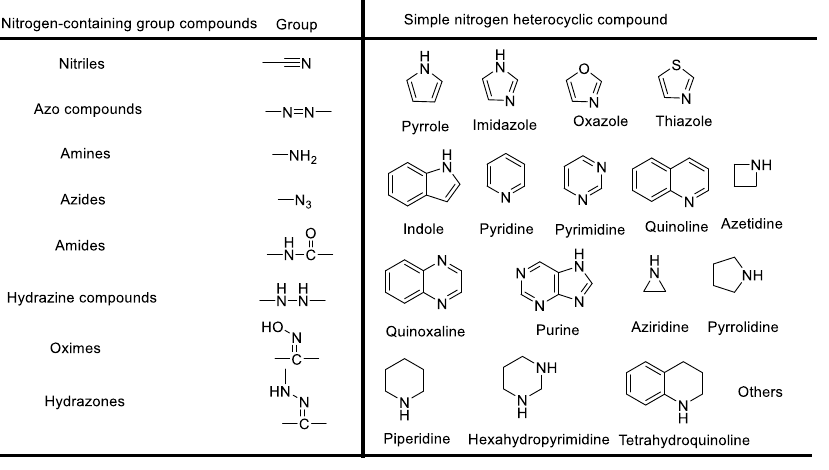
Figure 1. General classification of nitrogen-containing functionalized compounds in the organic chemistry field.